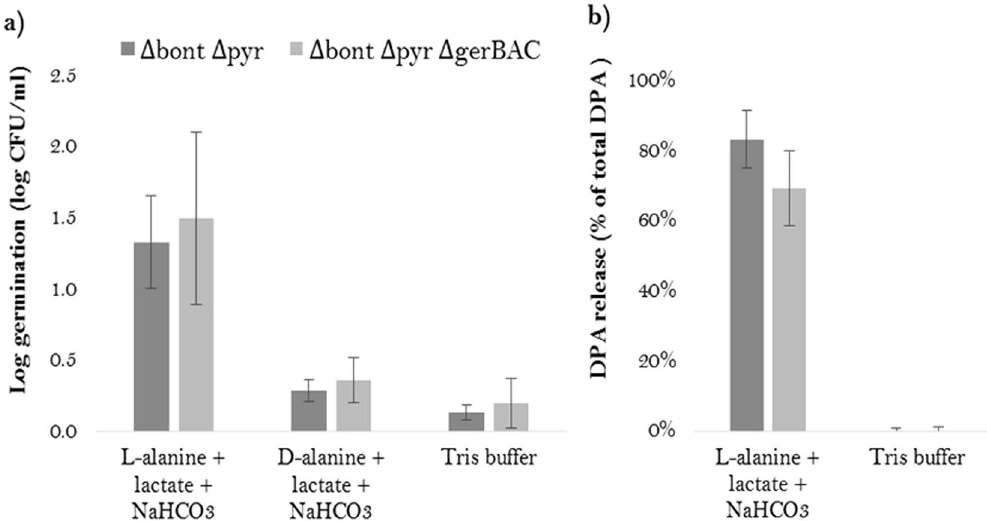
Figure 2. Spore germination of ∆ gerBAC spores compared to the parental strain, in L-ala/L-lact/NaHCO 3 (all at 50 mM) in 100 mM Tris-HCl buffer (pH 7.4). ( a ) Germination assessed by loss of heat resistance (65 °C/10 min), after incubation of heat-activated spores for 4 h at 30 °C in the germinant mixture. D-alanine (50 mM) was used to demonstrate the stereospecific action of germination induction in comparison to L-alanine. Means + / − standard deviations are shown of three experiments using independent spore crops. No significant differences were found (p > 0.05) between the two strains. ( b ) DPA release of heat-activated